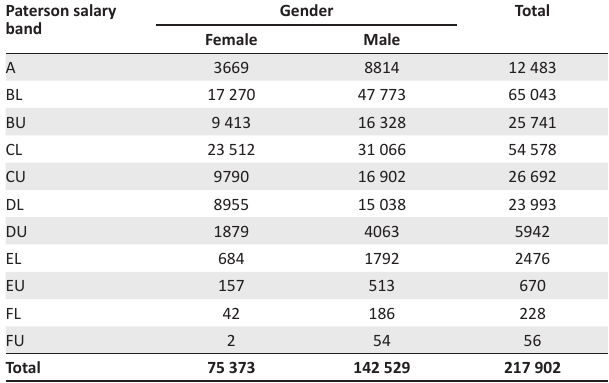
TABLE 3: Population frequency by salary band and gender. Paterson salary band